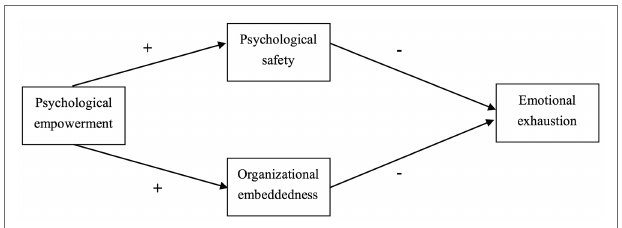
FIGURE 1 | Hypothesized theoretical